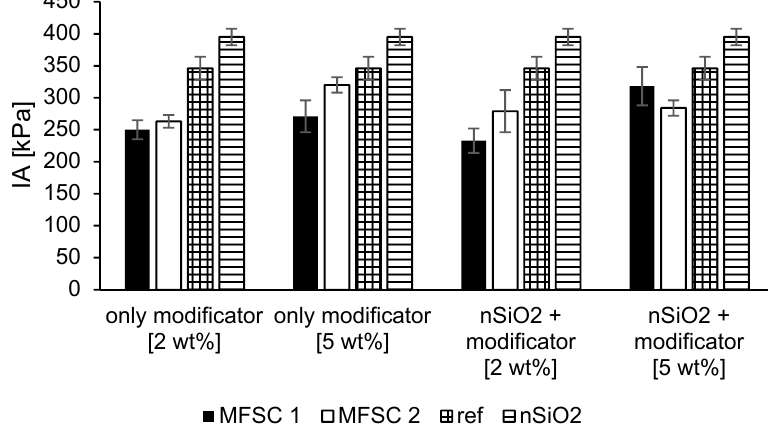
Figure 9. The ice adhesion of produced samples.